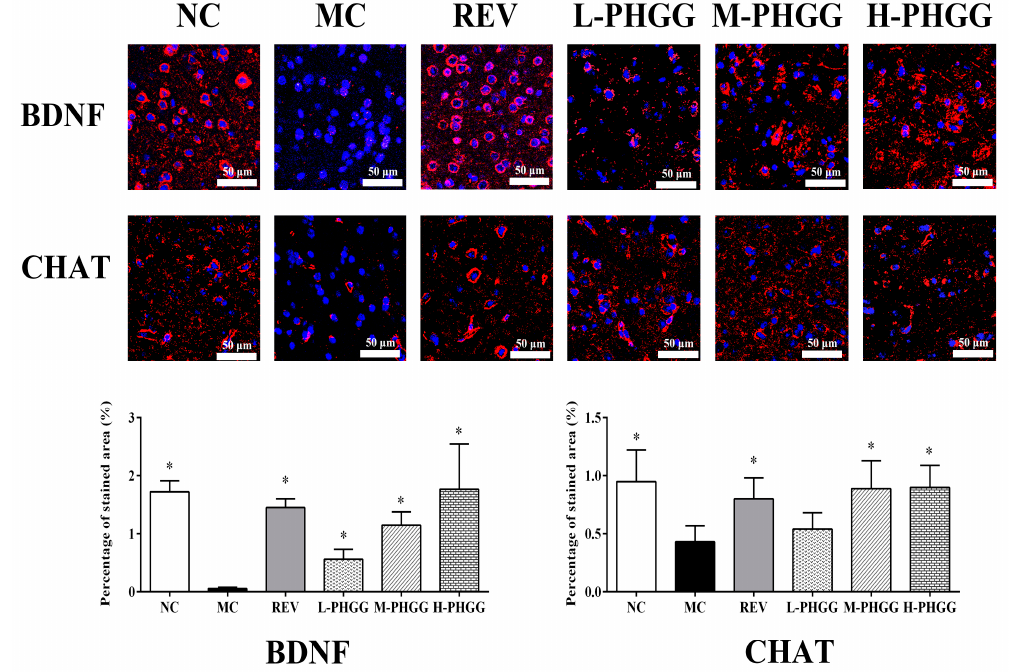
Figure 2. E ff ects of PHGG on the protein expression of brain-derived neurotrophic factor (BDNF) and choline acetyltransferase (ChAT) in the rat hippocampus. Representative images of immunofluorescence staining (600 × ) of BDNF and ChAT are shown. Cell nuclei are stained in blue, and BDNF / CHAT protein are stained in pink. The percentage of the BDNF- / CHAT-stained area is presented. Statistical significance between the model control group and the other groups was determined by the Kolmogorov–Smirnov test and Levene’s test for hypotheses of normality and variance homogeneity, followed by Student’s t -test or Mann–Whitney’s U non-parametric test. * p < 0.05 compared with the model control group. NC, normal control (saline); MC, d -gal model control (saline); REV, resveratrol (20 mg / kg / day);